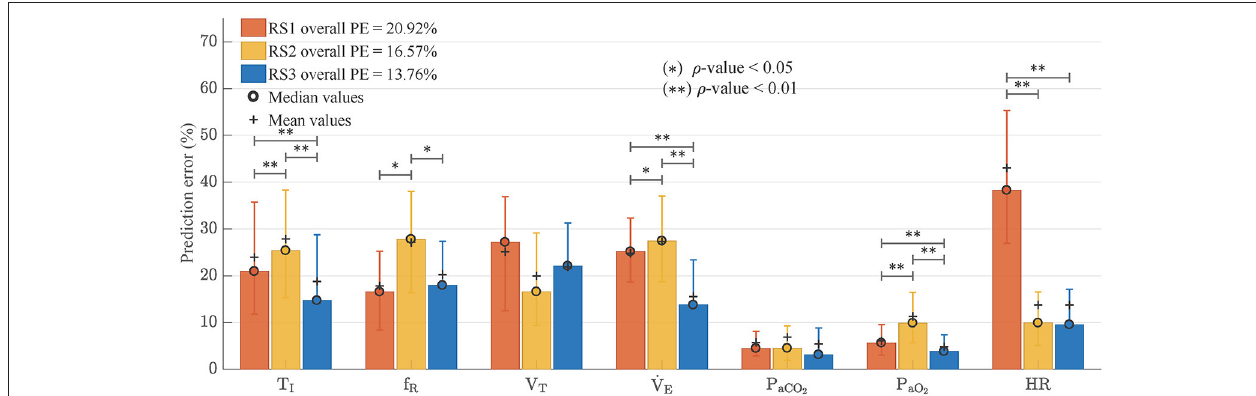
FIGURE 9 | Prediction errors (PE) obtained by each one of analyzed models. Bars graph shows median values and error bars indicate interquartile distance (range of values from 25 to 75% quartile). Wilcoxon signed-rank test was used to find statistically significant differences between the obtained PE. (*) for ρ < 0.05 and (**) for ρ <